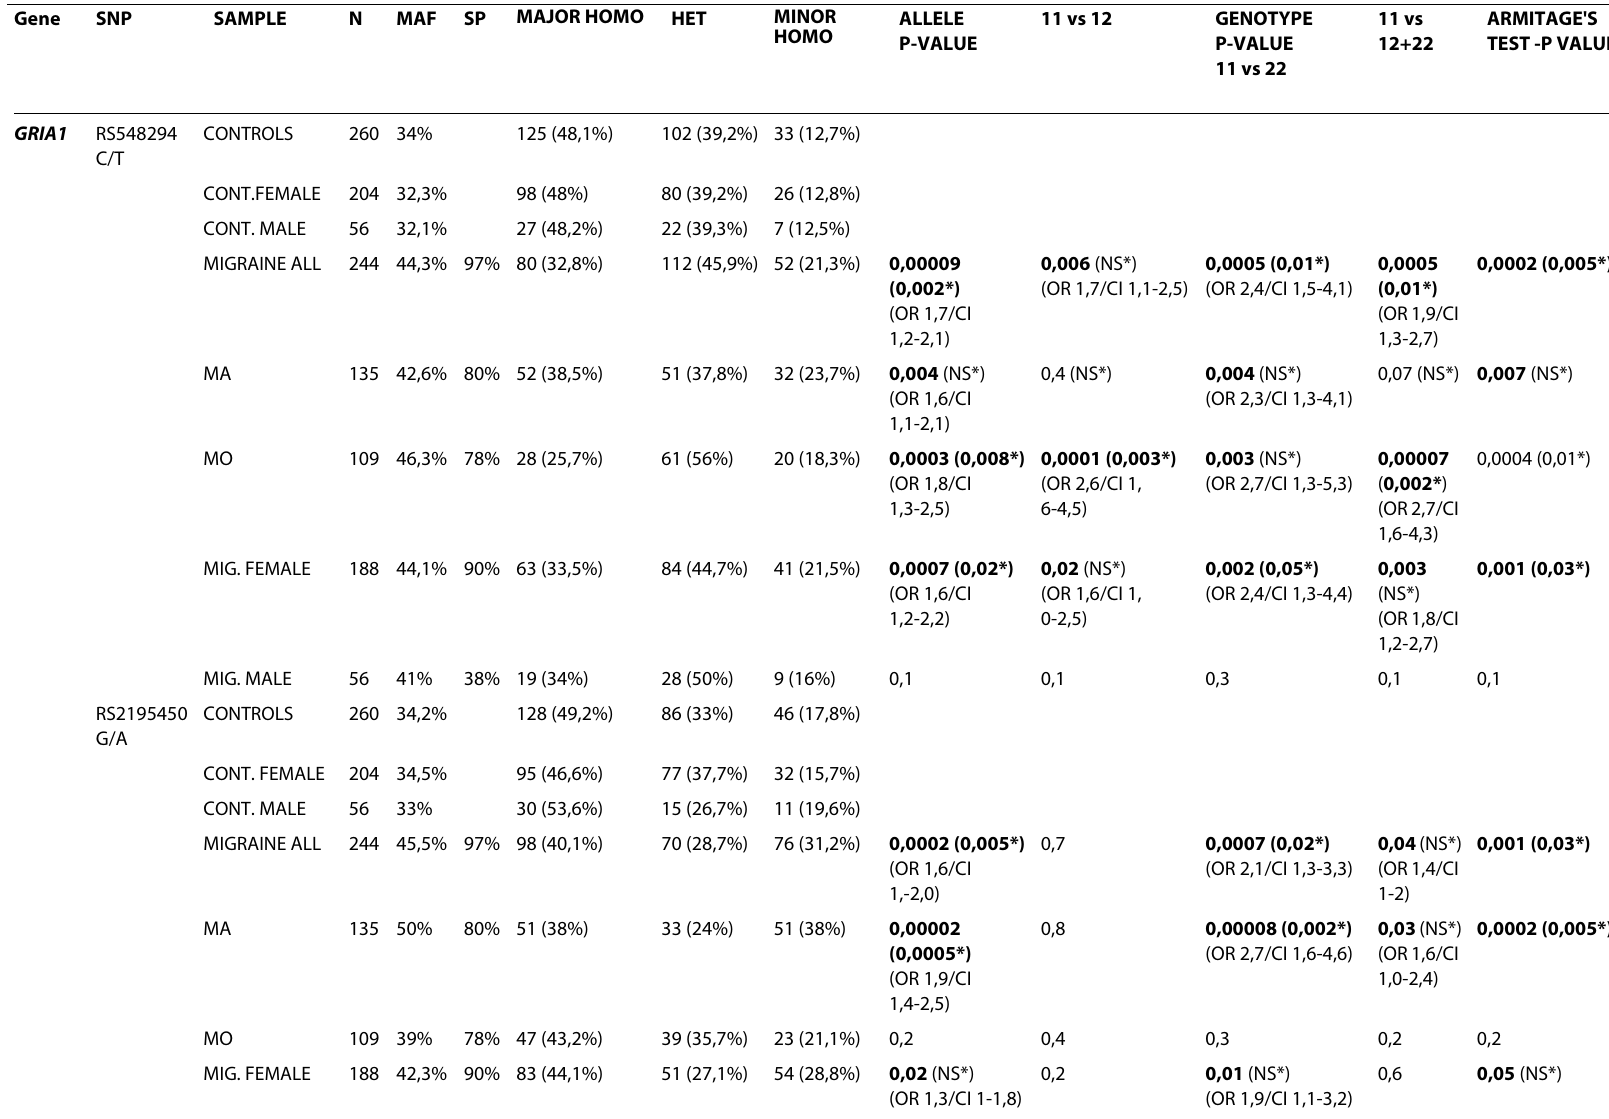
Table 2: Allele and genotype frequencies of GRIA1 and GRIA3 polymorphisms in Italian patients and controls and association results